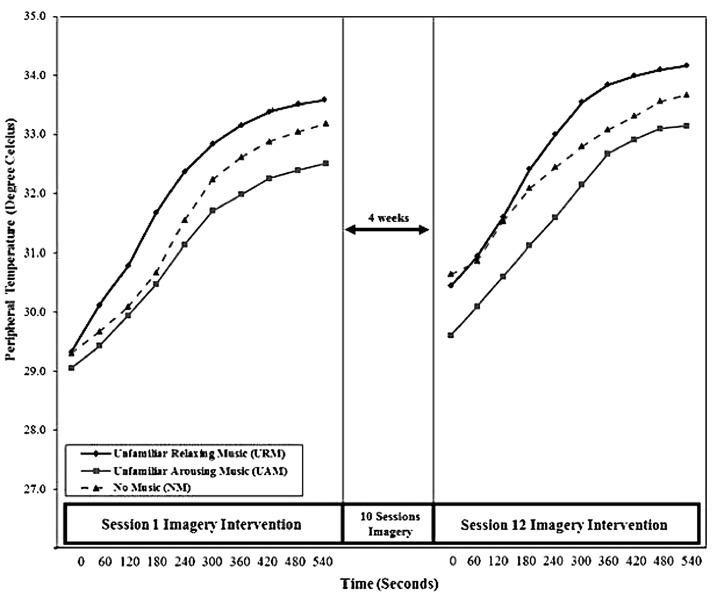
Mean peripheral temperature (PT) from t0 to t540 across Sessions 1 and 12.